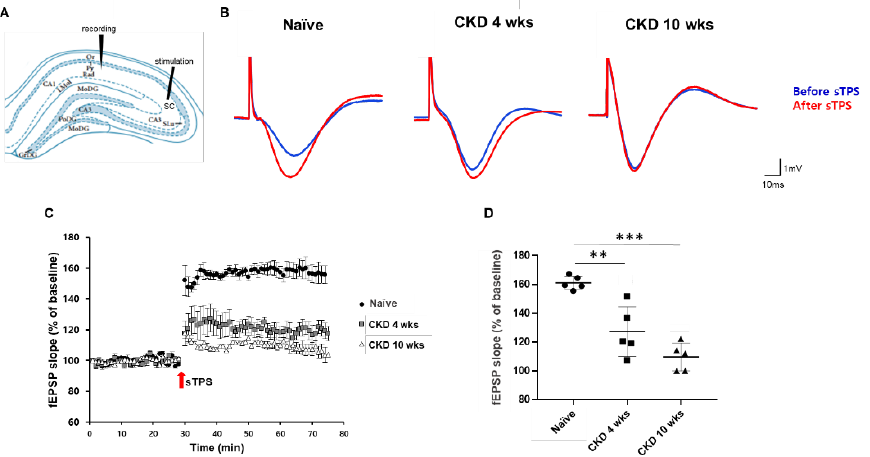
Figure 4. Decreased fEPSP in the hippocampal CA1 regions of CKD model rats. A schematic diagram showing the in vivo experimental setup for recording fEPSP in the rat hippocampus ( A ). Representative traces for fEPSP in the hippocampal CA1 region before and after single-pulse stimuli in naïve and CKD rats ( B ). The amplitude of evoked fEPSP ( C ) and the slope changes ( D ) following LTP in CKD rats were attenuated compared with naïve rats. The arrows in panel B indicate the time point of strong theta-patterned stimulus (sTPS) application for LTP. Data are presented as means ± SEM. ** p < 0.01, *** p < 0.001 by one-way analysis of variance, fEPSP: n = 5/group.